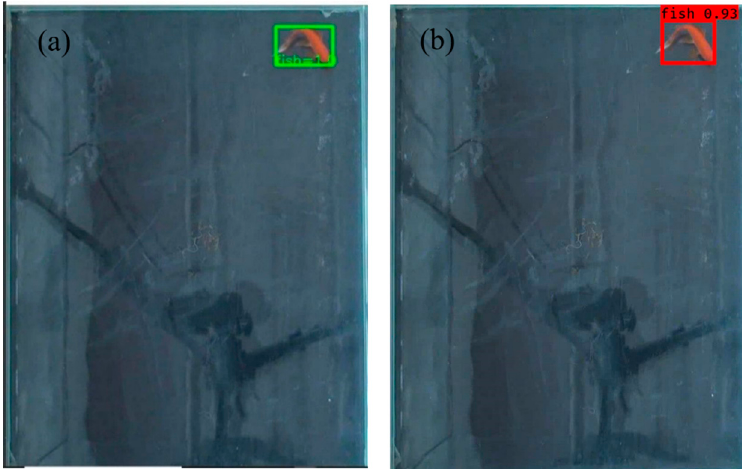
Figure 3. Recognition results of fish. ( a ) recognition by Faster R-CNN, ( b ) recognition by YOLO-V3.